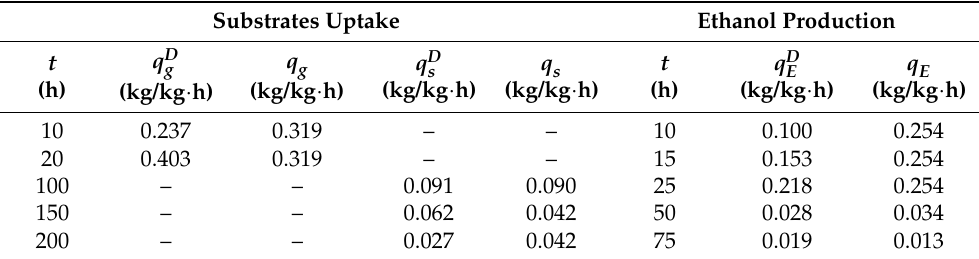
Table 7. Specific substrate uptake and ethanol production rates.